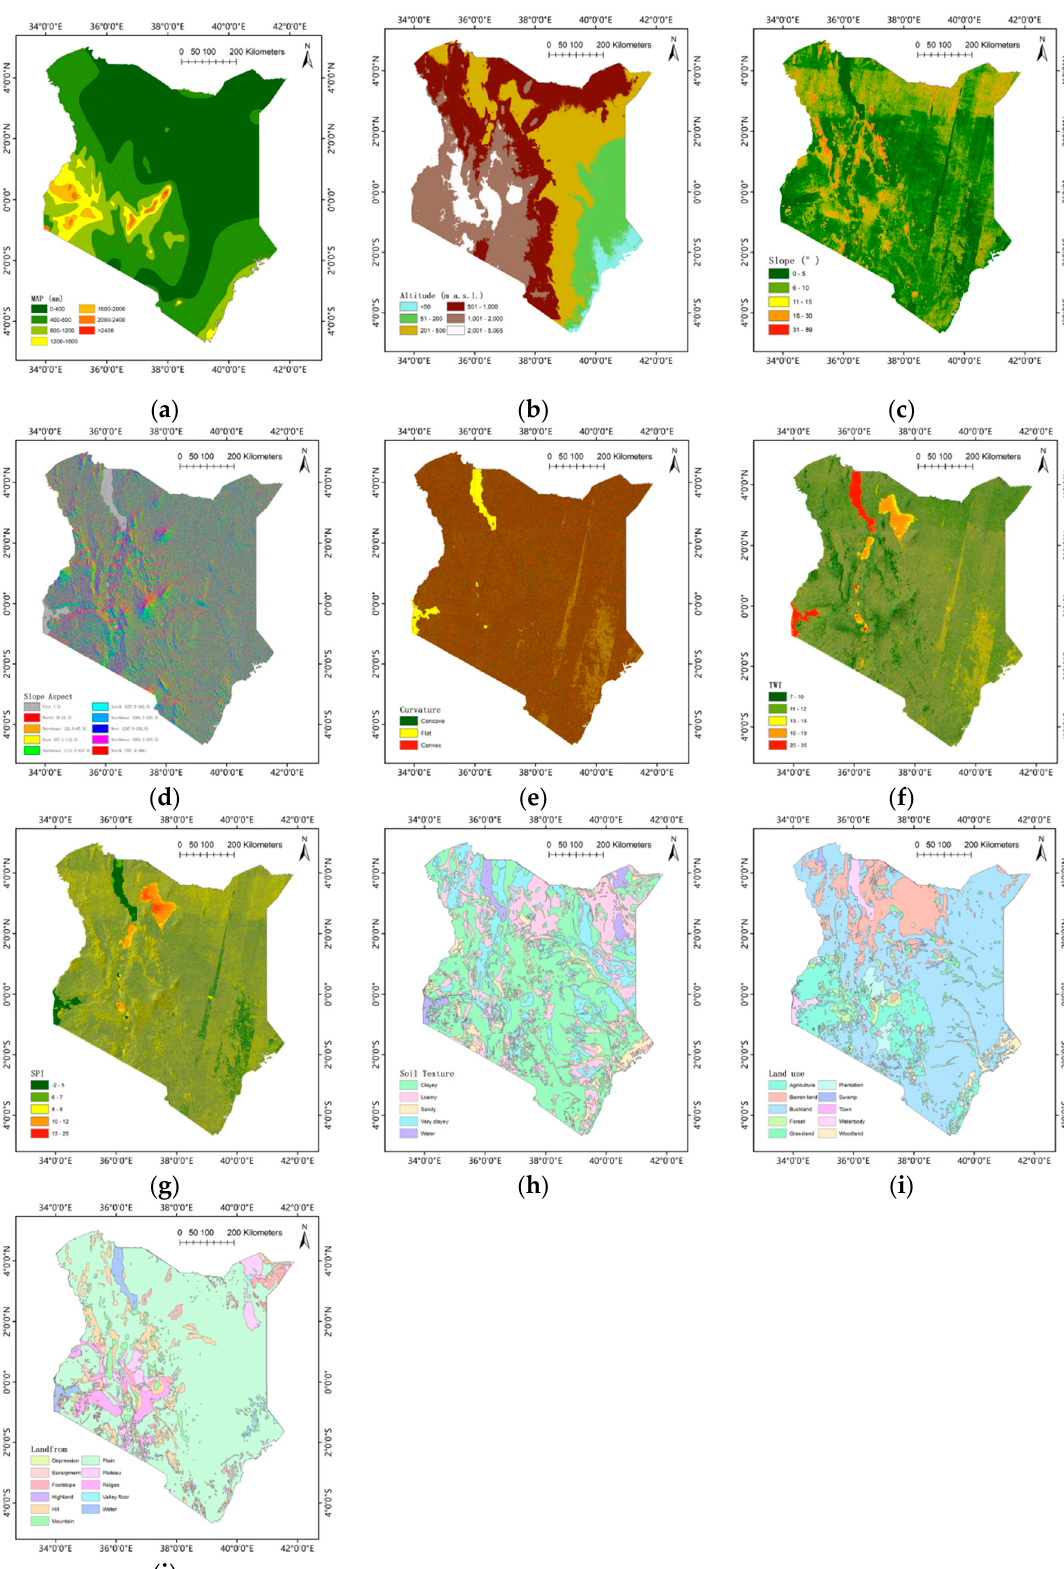
Figure 3. List of landslide contribution factors: ( a ) MAP; ( b ) altitude; ( c ) slope; ( d ) aspect; ( e ) curvature; ( f ) TWI; ( g ) SPI; ( h ) soil texture; ( i ) land use; ( j ) landform.